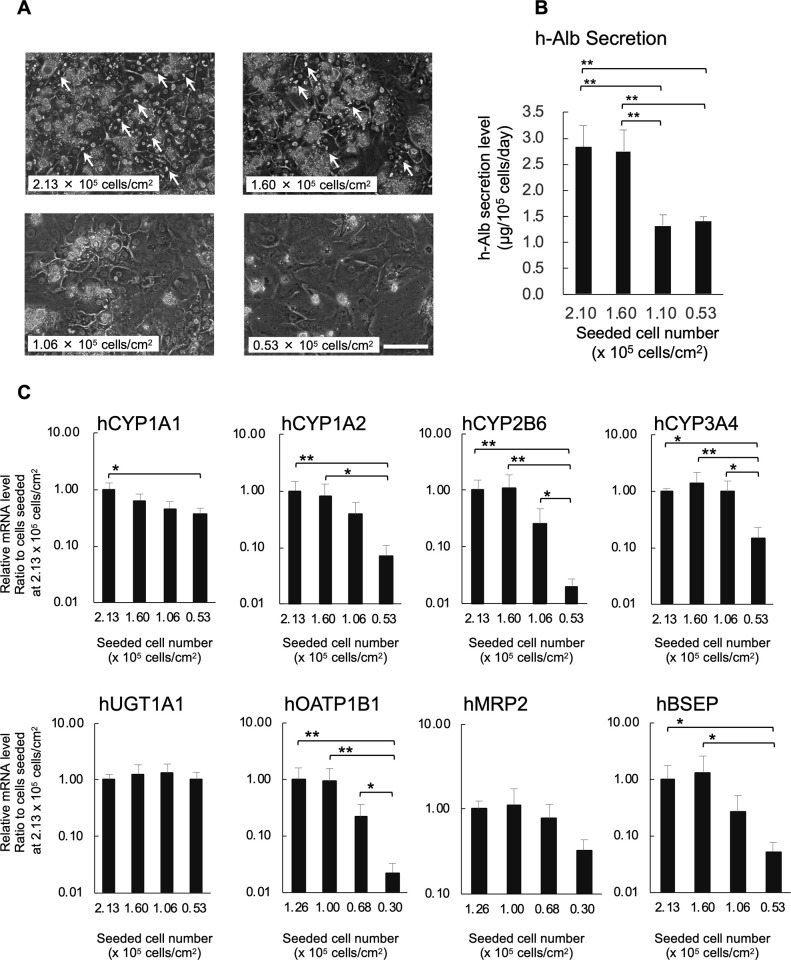
cFHHs cultured at different cell densities.A: Phase contrast microphotographs of cFHHs plated at 0.53, 1.06, 1.60, and 2.13×105 cells/cm2 and cultured for 7 days. Arrows show bile canalicular structures. Scale bar denotes 100 μm. B: h-Alb levels in culture supernatant of cFHHs cultured at different cell densities. These results represent the mean ± SD of three independent experiments. **p<0.01 C: Gene expression levels of human phase I and II enzymes in cFHHs plated at 0.53, 1.06, 1.60, and 2.13 × 105 cells/cm2 and cultured for 7 days. Each gene expression level was measured by qPCR. These results represent the mean ± SD of three independent experiments. *p < 0.05, **p < 0.01.